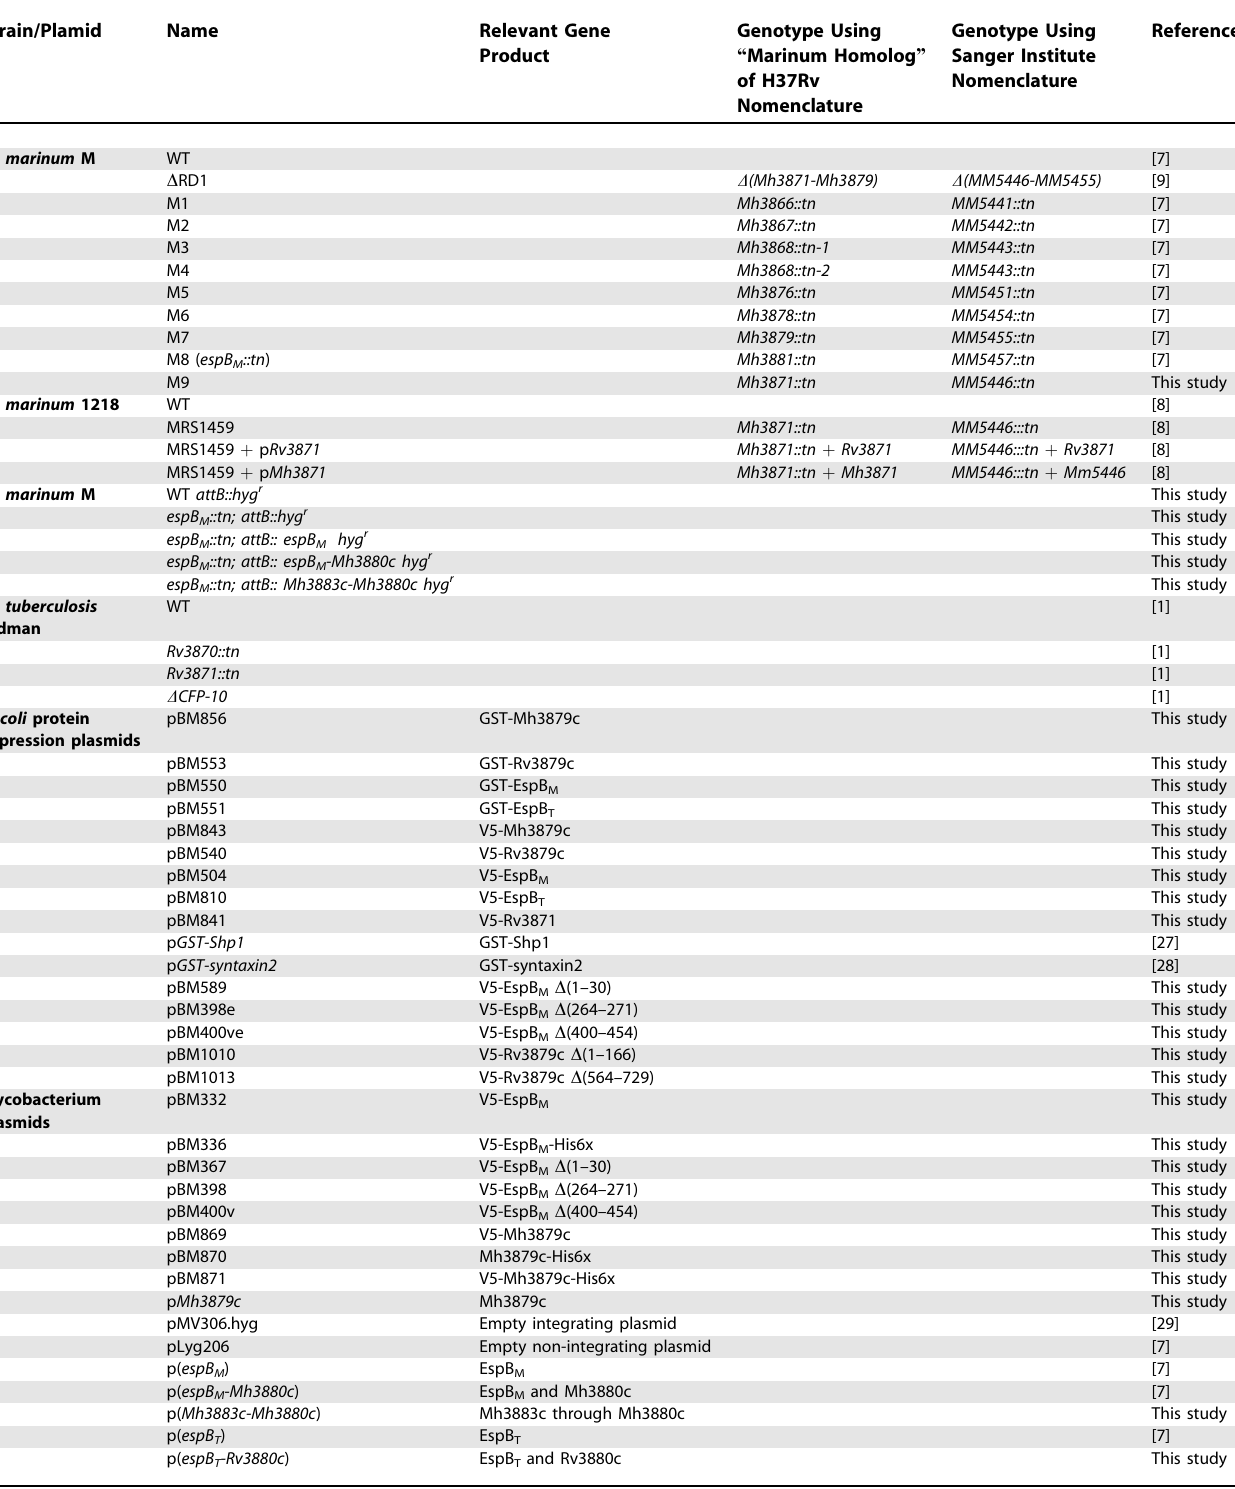
Table 1. List of Bacterial Strains and Plasmids Used in This Study